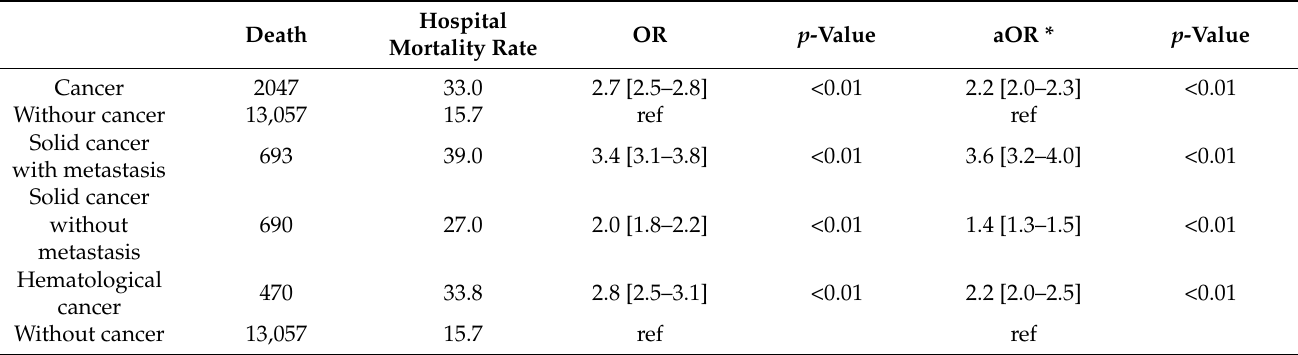
Table 4. Logistic regression to study the risk of in-hospital death regarding patients hospitalized in France for COVID-19 (from 1 March 2020, to 30 April 2020) with cancer or